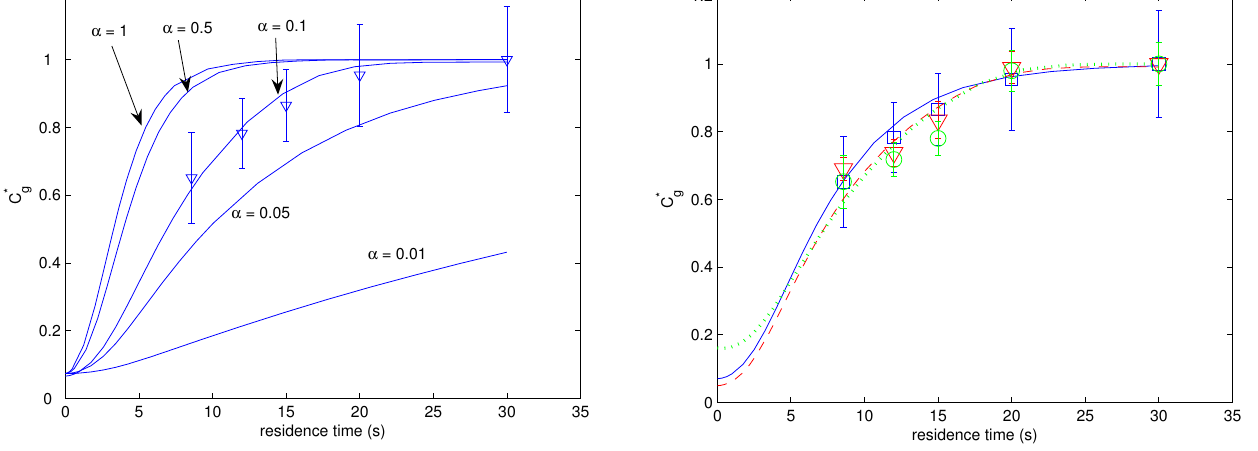
Fig. 4. Measured and simulated dimensionless vapor build-up pro- files. Blue squares and solid: adipic acid, C 0 =390µgm − 3 , d p , cs =65nm; red triangles and broken: pimelic acid, C 0 =307µgm − 3 , d p , cs =67nm; green circles and dotted: suc- cinic+adipic+pimelic+azelaic acid mixture, C 0 =313µgm − 3 , d p , cs =61nm. T in =25 ◦ C and T w =40 ◦